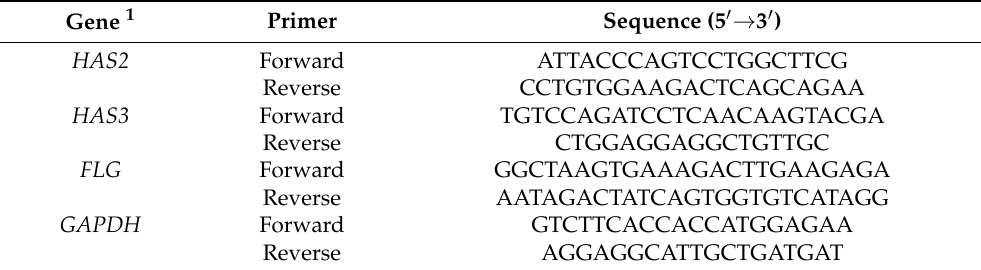
Table 1. Primer sequences of human origin used for qRT-PCR. Gene